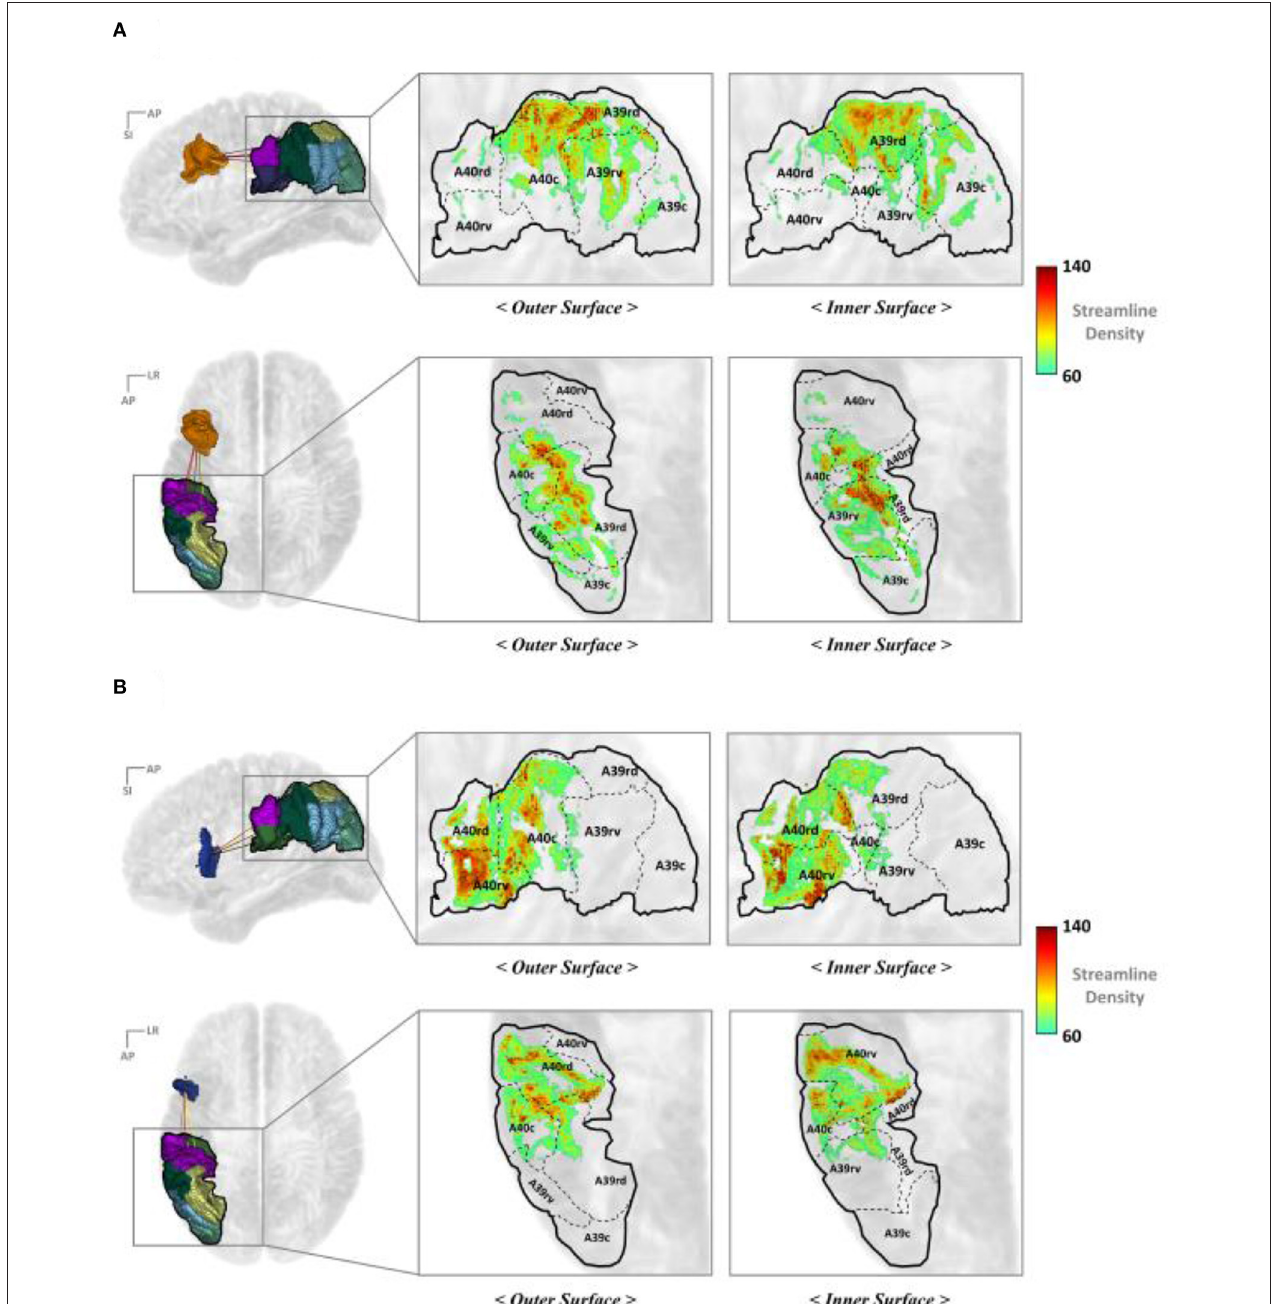
FIGURE 6 | Mapping the end points of the streamline to the IPC (A) IFJ–IPC streamlines and (B) A44v–IPC streamlines. A8m, medial area 8; A8dl, dorsolateral area 8; A8vl, ventrolateral area 8; A9l, lateral area 9; A9m, medial area 9; A9/46d, dorsal area 9/46; A10l, lateral area 10; A10m, medial area 10; A11l, lateral area 11; A11m, medial area 11; A12/47l, lateral area 12/47; A12/47o, opercular area 12/47; A13, area 13; A14m, medial area 14; A39c, caudal area 39; A39rd, rostrodorsal area 39; A39rv, rostroventral area 39; A40c, caudal area 40; A40rd, rostrodorsal area 40; A40rv, rostroventral area; 40A46, area 46; A44d, dorsal area 44; A44op, opercular area 44; A44v, ventral area 44; A45c, caudal area 45; A45r, rostral area 45; IFJ, inferior frontal junction; IFS, inferior frontal sulcus.